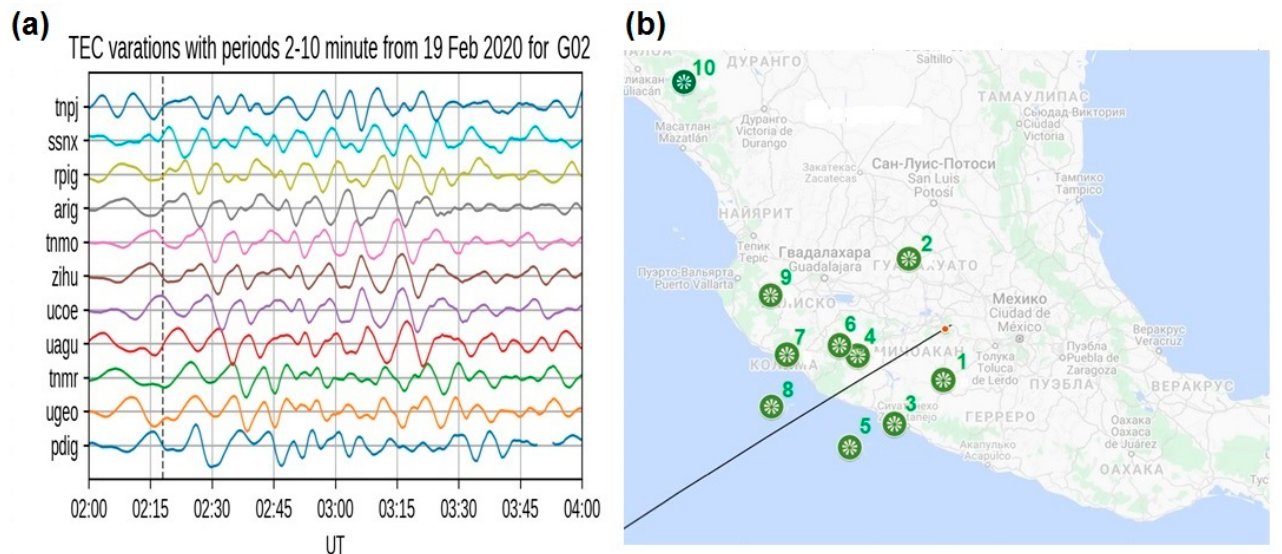
Figure 14. LoSs to PRN02: ( a ) dIv time series; ( b ) sub-ionospheric point locations numbered in order of wave-packet disturbance registration.